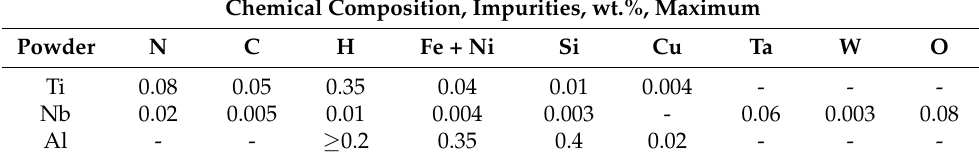
Table 1. Chemical composition of the powders it.